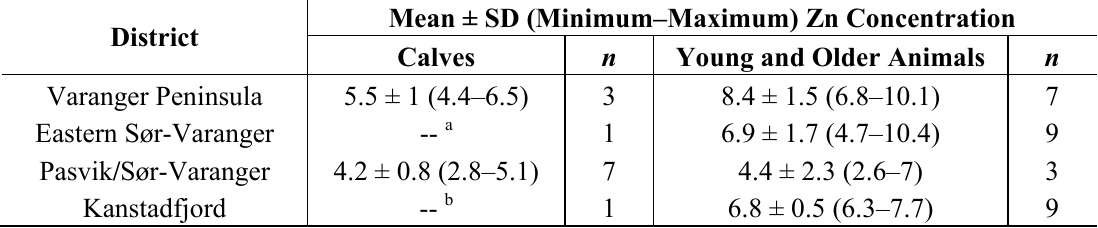
Table 3. Age stratified Zn Concentration (mg/100 g wet weight (ww)) in reindeer meat from districts with mixed age groups.